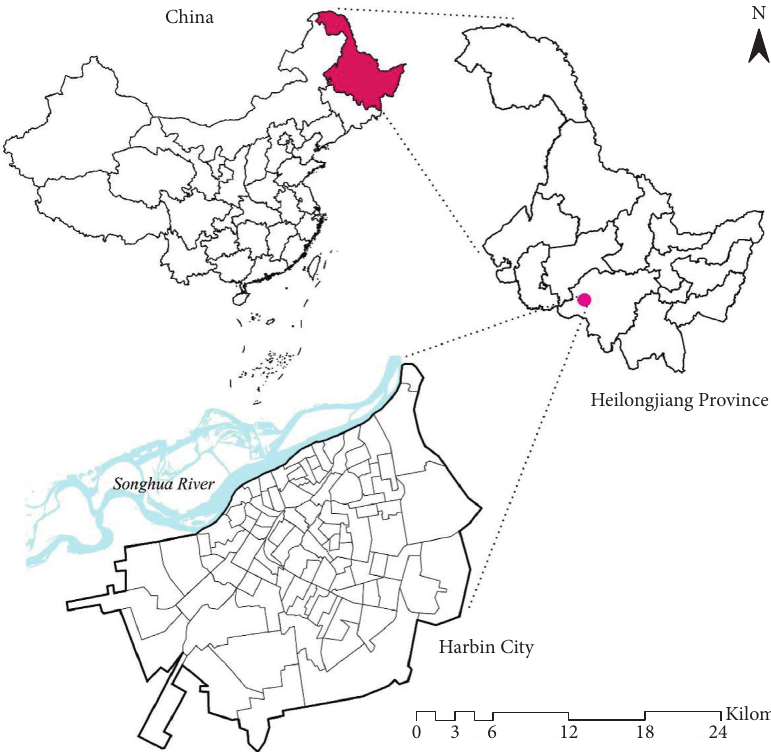
Figure 1: Location of the study area (Harbin